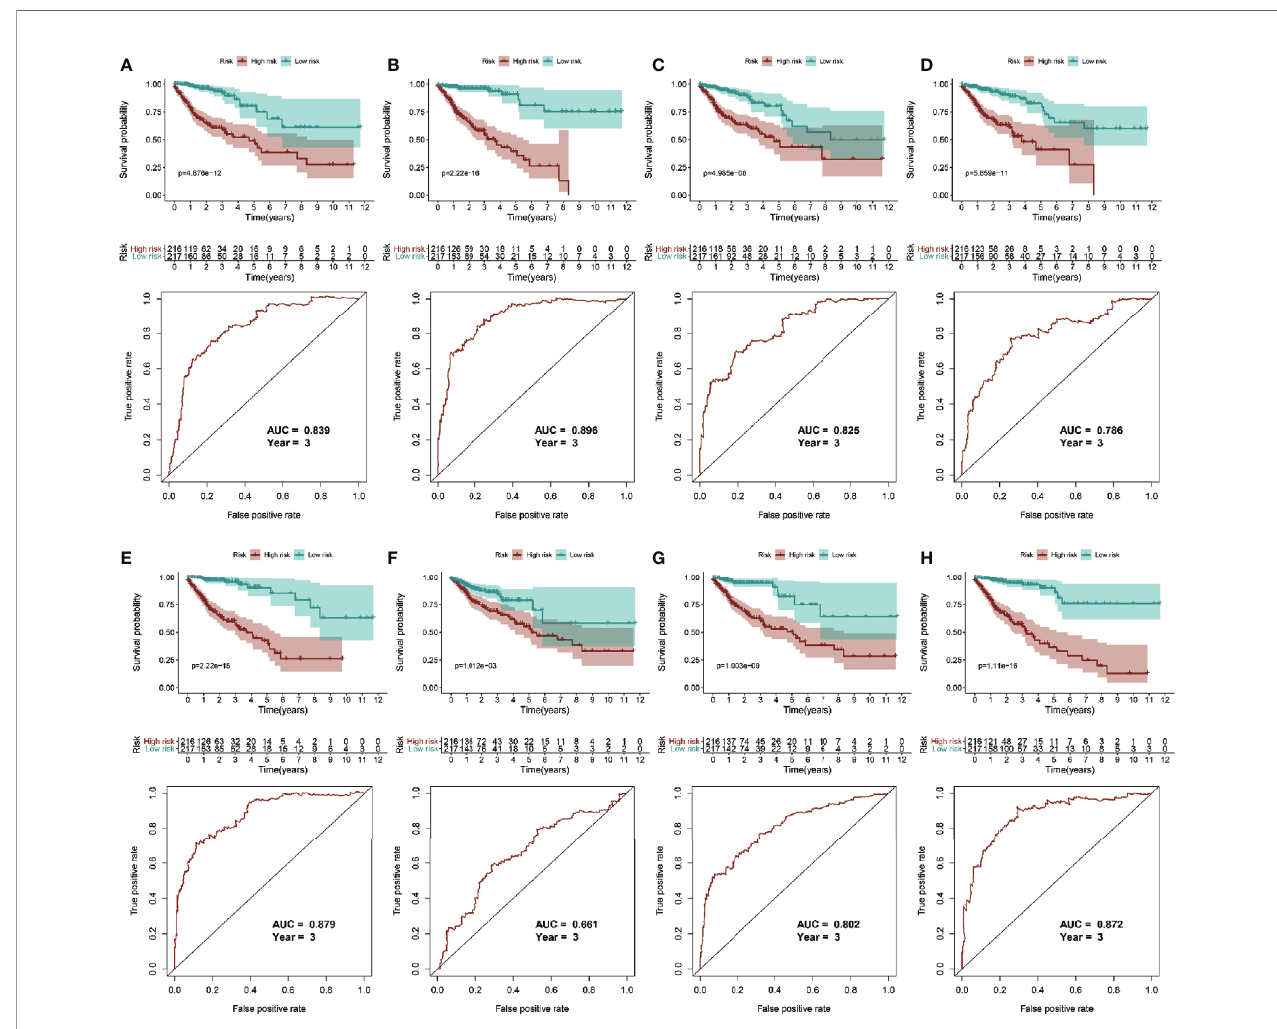
FIGURE 4 | Validation of AS model with survival results. (A – H) represents the AS events AA, AD, AP, AT, ES, ME, RI, and total events, respectively. In each fi gure, the top section shows Kaplan-Meier curves of prognostic signatures in patients with CRC, and the bottom section shows the ROC curves of prognostic predictors in patients with CRC at 3